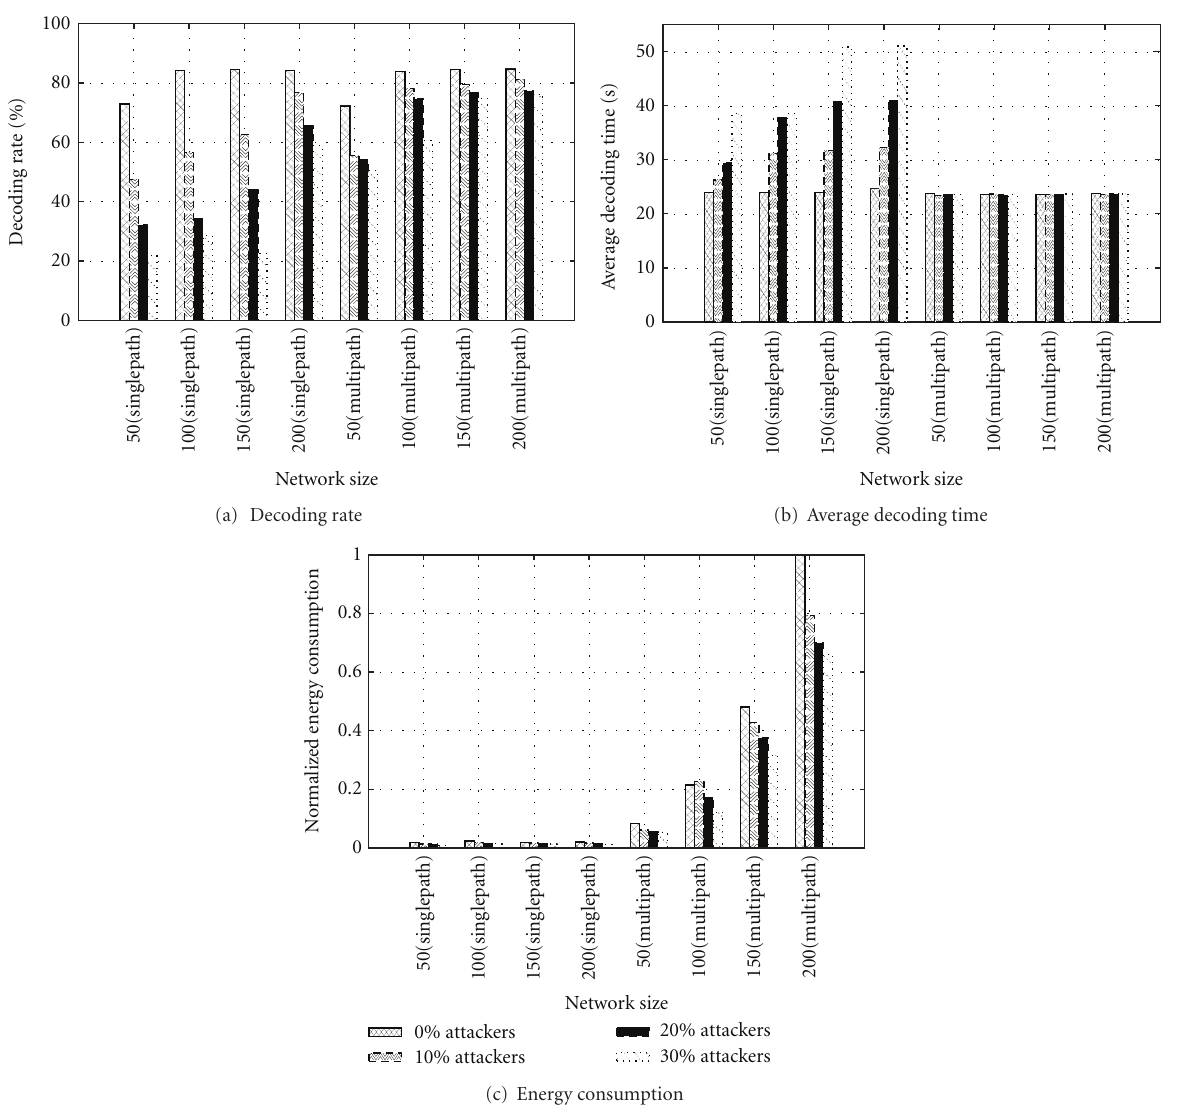
Figure 2: Performance results when single path network coding and multipath network coding are confronting to selective forwarding